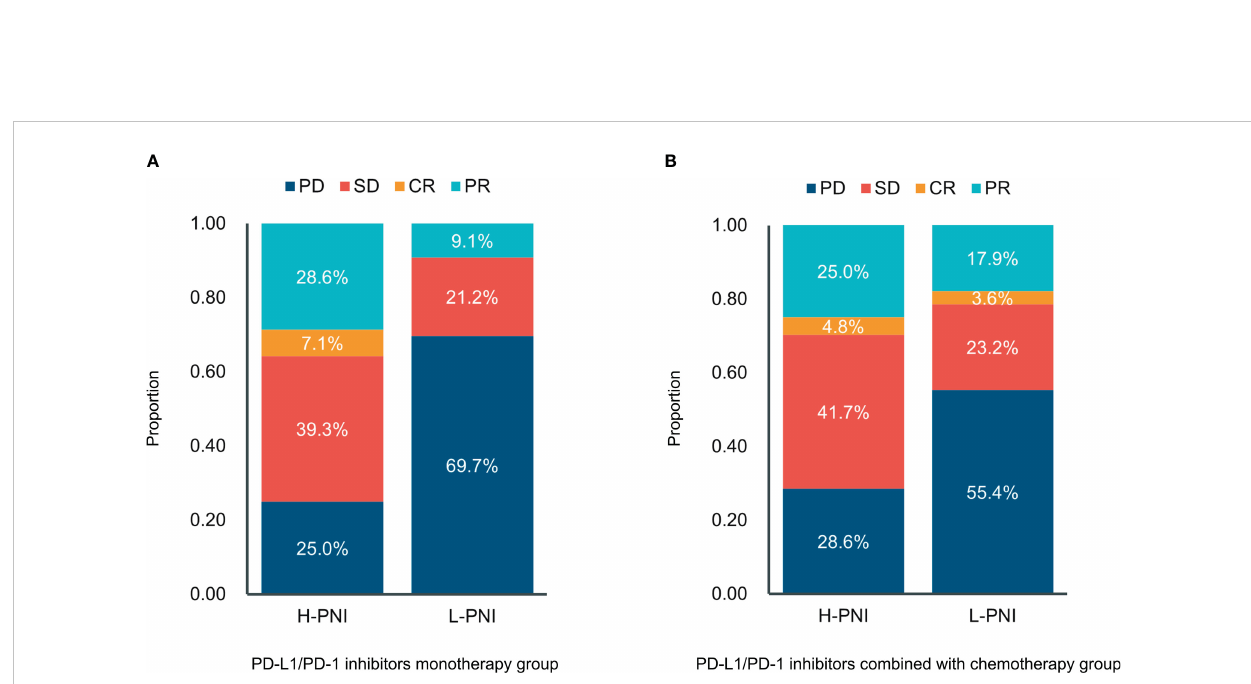
FIGURE 3 Distribution between responses and the PNI groups in patients with (A) PD-L1/PD-1 inhibitors monotherapy and (B) PD-L1/PD-1 inhibitors combined with chemotherapy. CR, complete response; PR, partial response; SD — stable disease; PD, progressive